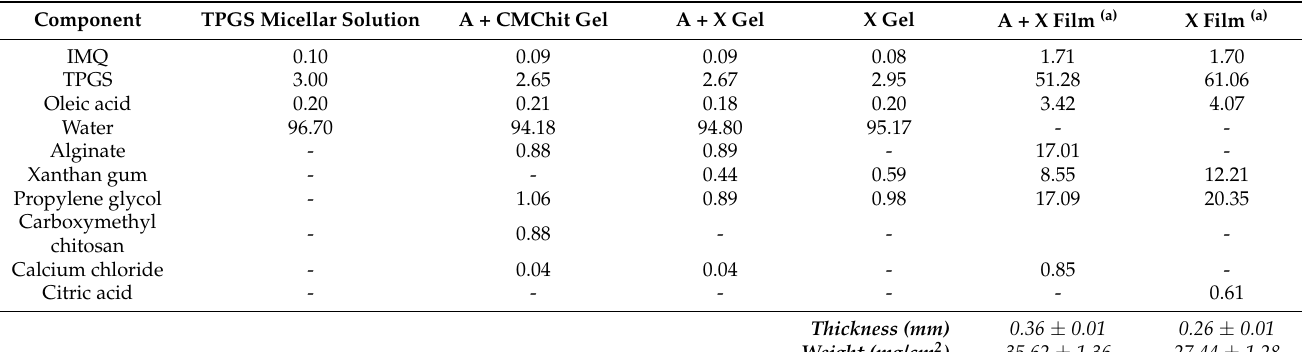
Table 1. Percent composition ( w / w ) of the formulations